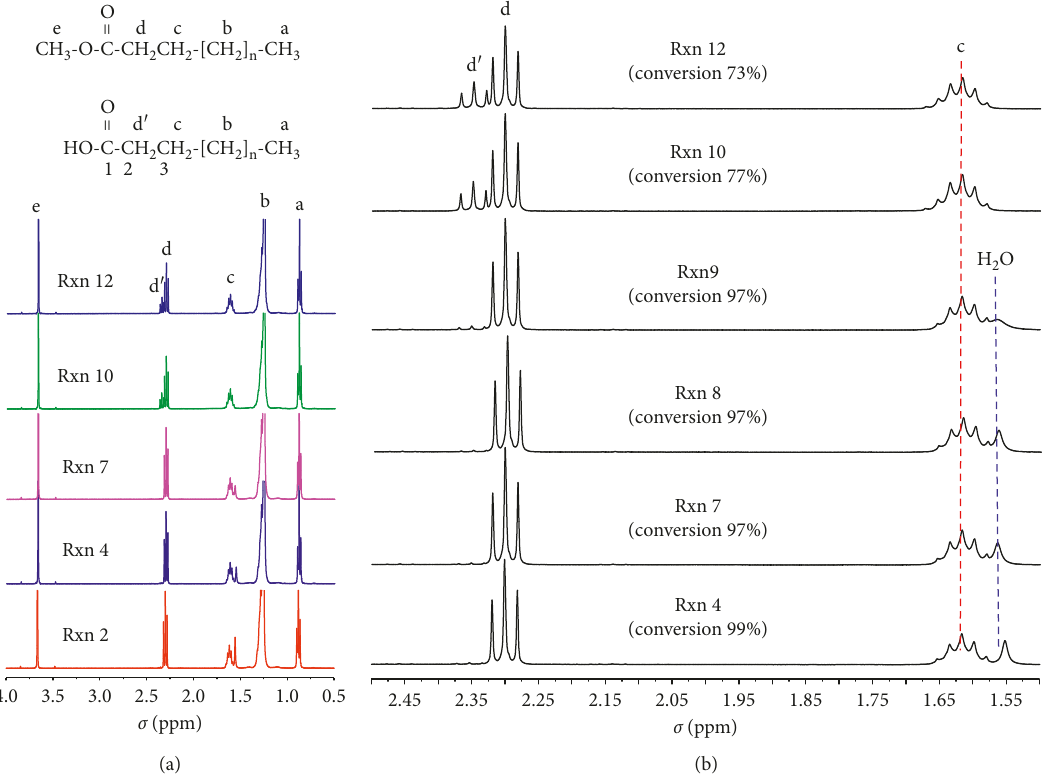
Figure 1: Comparison of NMR spectra using CDCl 3 of methyl-esterified products obtained from zinc stearate in various reaction conditions: a (0.86ppm), b (1.17–1.36ppm), c (1.62ppm), d (2.30 ppm), d (2.35 ppm), and e (3.67 ppm).